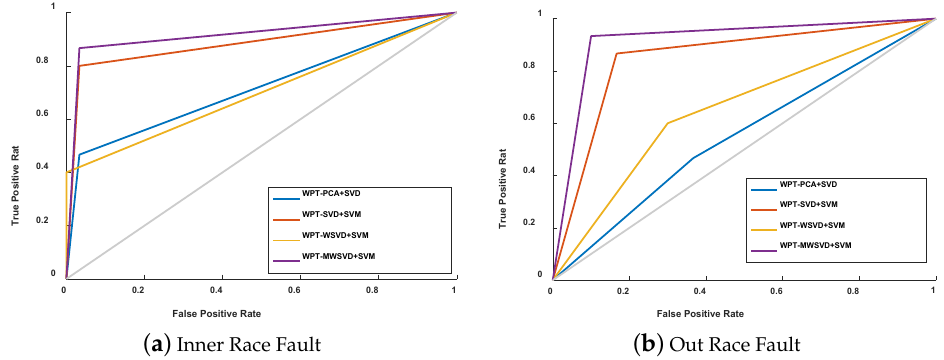
Figure 7. ROC curve diagram of the four algorithms on the fault diagnosis of the bearing inner race ( a ) and outer race ( b